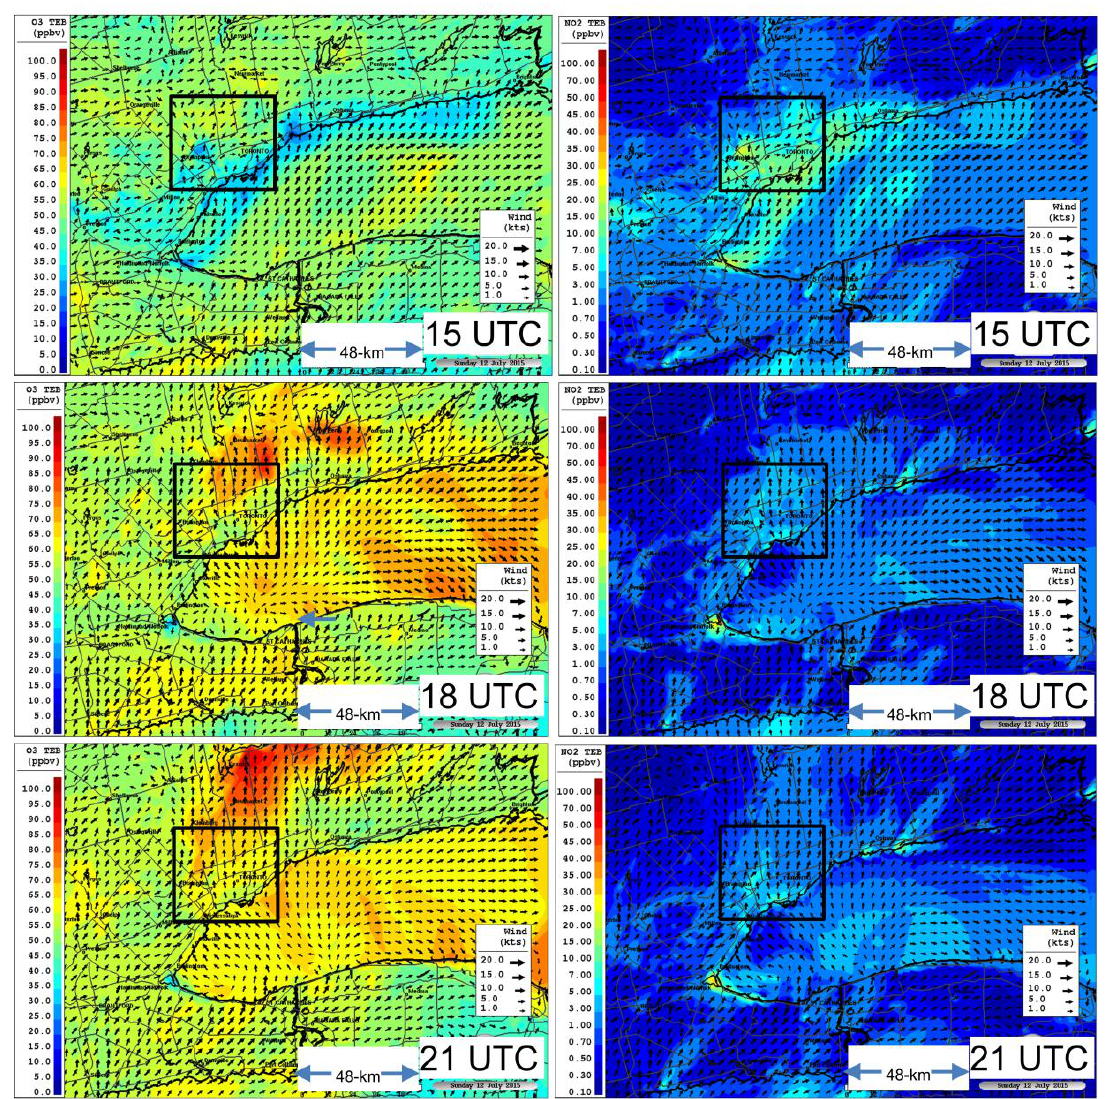
Figure 18. Modelled O 3 ( left column ) and NO 2 ( right column ) surface maps for at 15:00, 18:00 and 21:00 UTC 12 July 2015. The box shows the key region of interest where the lake breeze front transports pollutants north of Toronto.